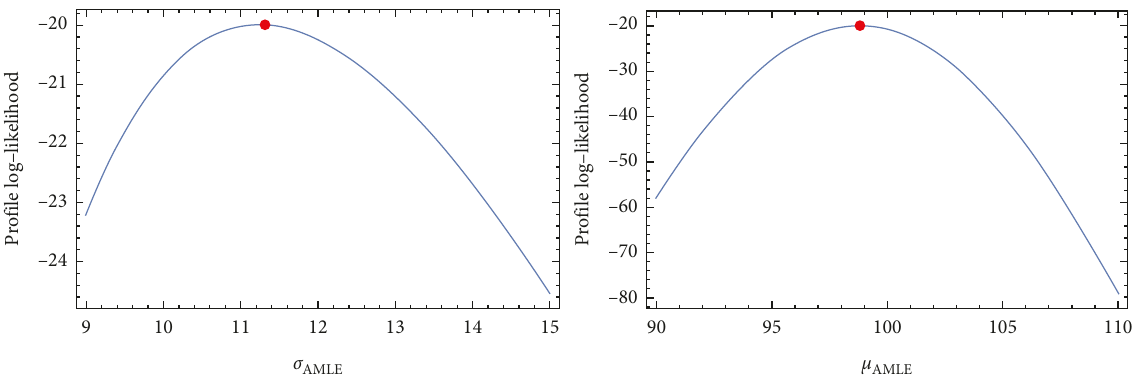
Figure 2: Behavior of log-likelihood function with AMLE parameters